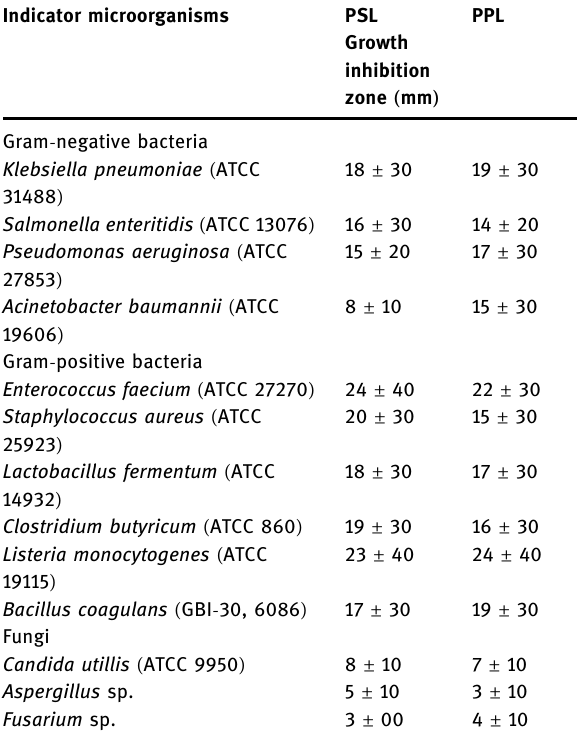
Table 6: Micorbiological activity of P. padus and P. serotina leaves extract Indicator